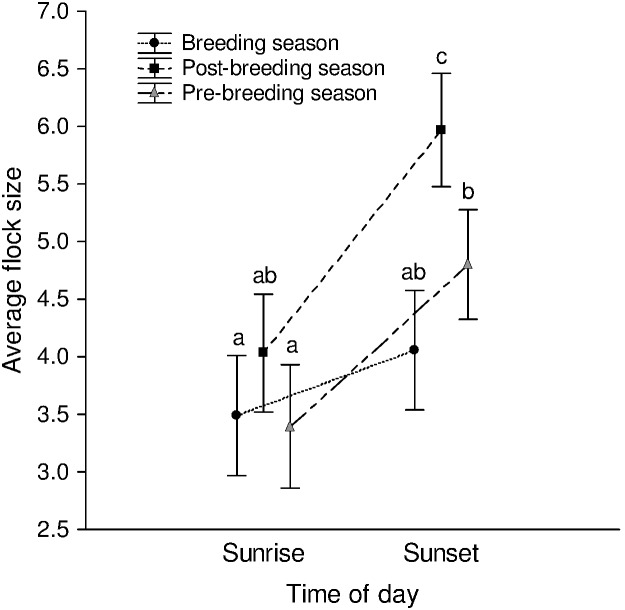
Average flock sizes during sunrise and sunset during different seasons.There was a significant interaction between time of day and breeding season in affecting average flock size (F
2,462 = 3.508, P = 0.031) (error bars are 95% CIs about the individual means). Significant pairwise comparisons based on Tukey’s tests are marked with different letters (c>b>a).